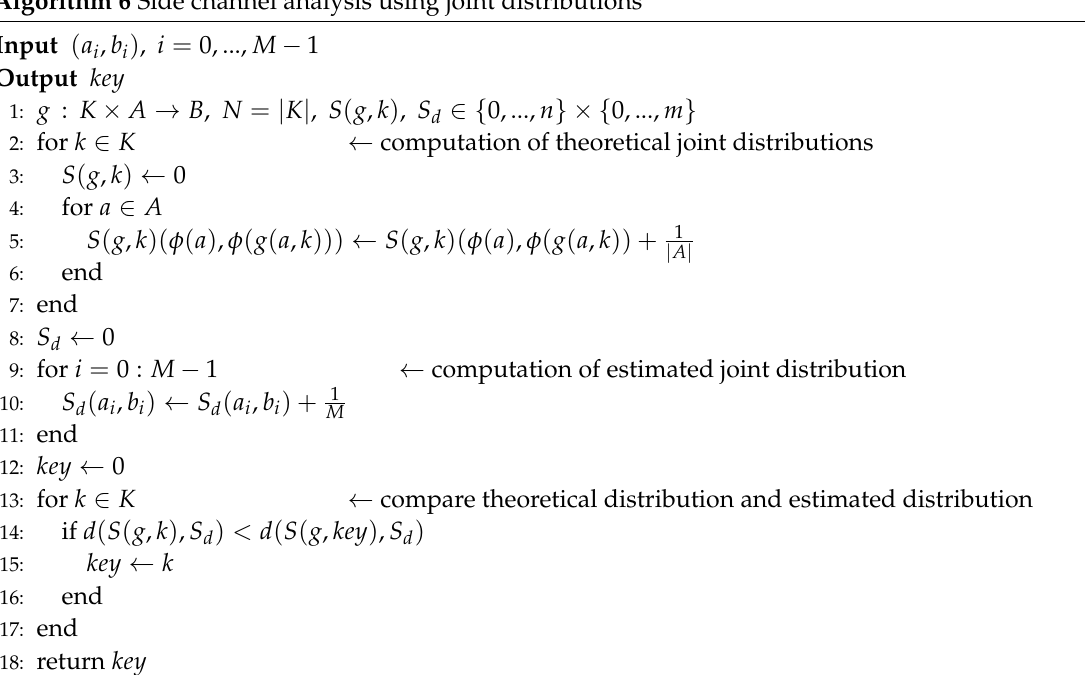
Algorithm 6 Side channel analysis using joint